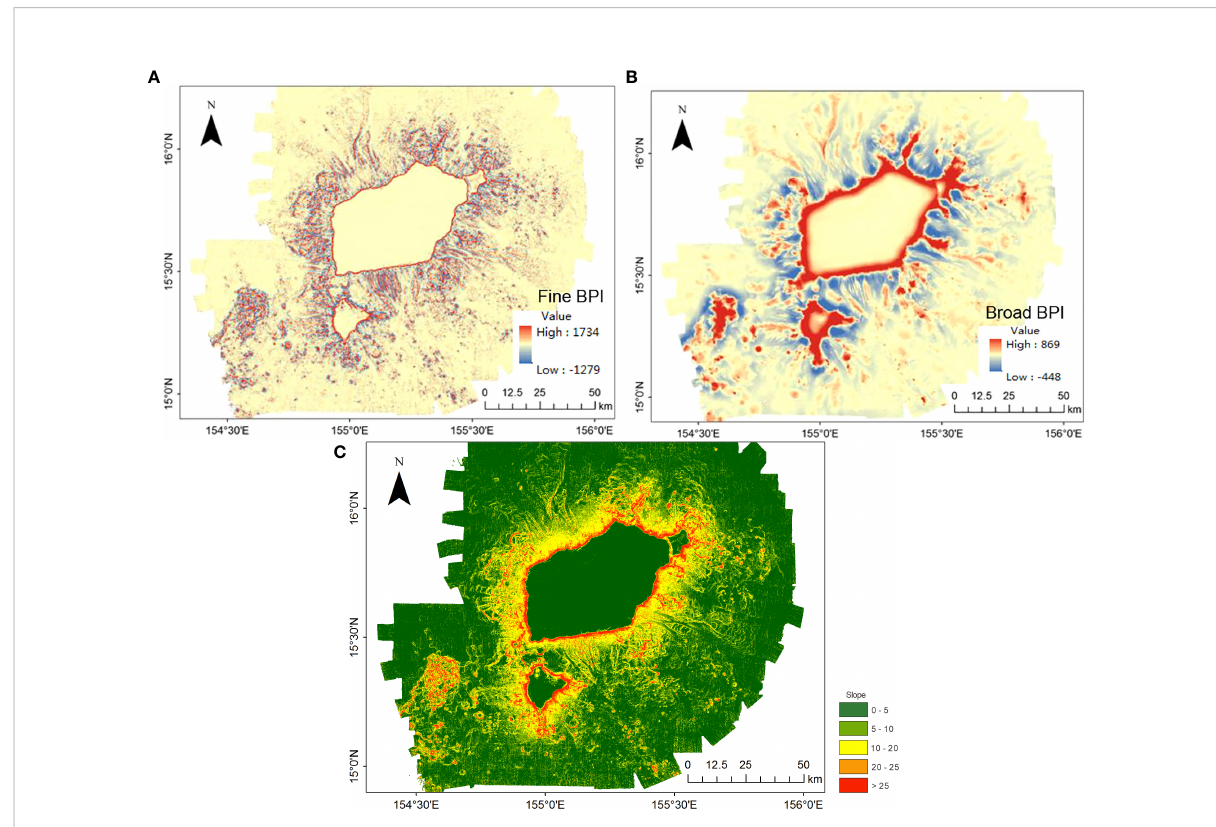
FIGURE 4 Bathymetric derivatives: (A) Fine-scale bathymetric position index (Fine-BPI), (B) Broad-scale bathymetric position index (Broad-BPI), and (C)